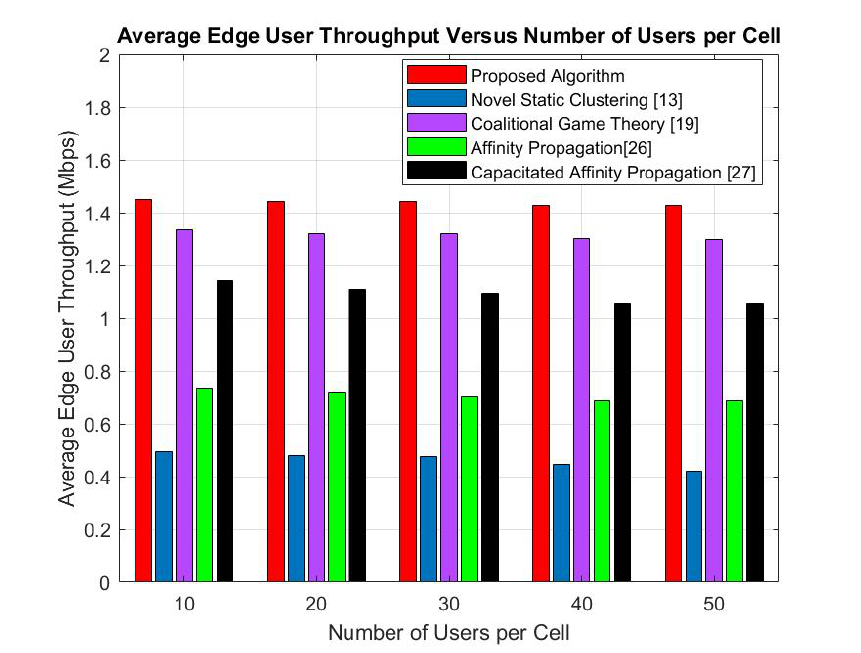
Figure 7. Average edge user throughput versus number of users per cell.